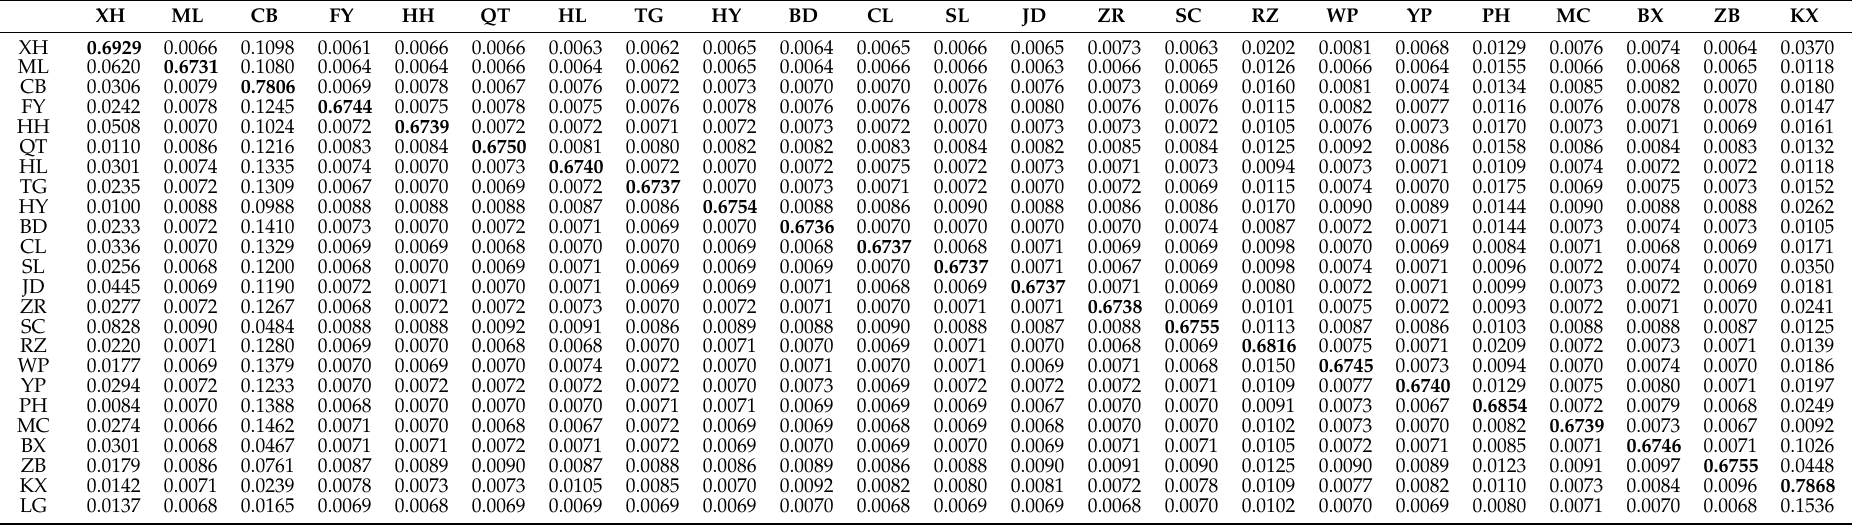
Table 6. Emigration rate (upper right) and immigration rate (lower left) across Spodoptera litura